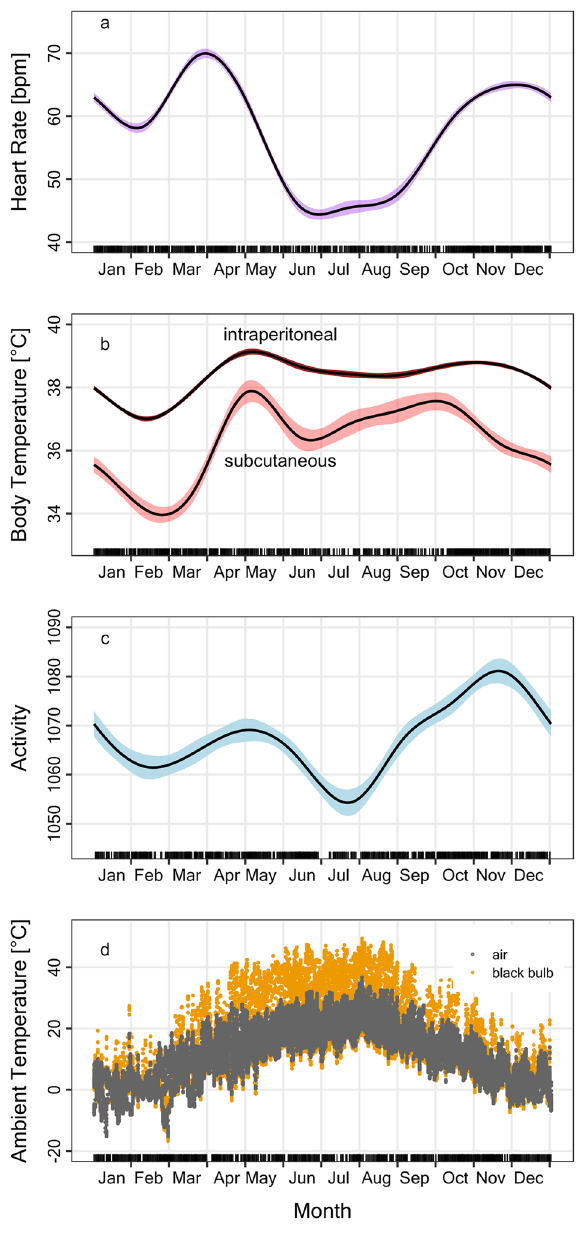
Figure 1. Seasonal time courses of ( a ) heart rate, ( b ) body temperature, ( c ) activity in female wild boars, as well as ( d ) air and black-bulb temperature at the study site. ( a – c ) Show predictions from mixed models (GAMMs) that adjusted for individual levels of the ten females. Coloured areas around the lines are 95% confidence intervals. ( d ) Shows temperatures as